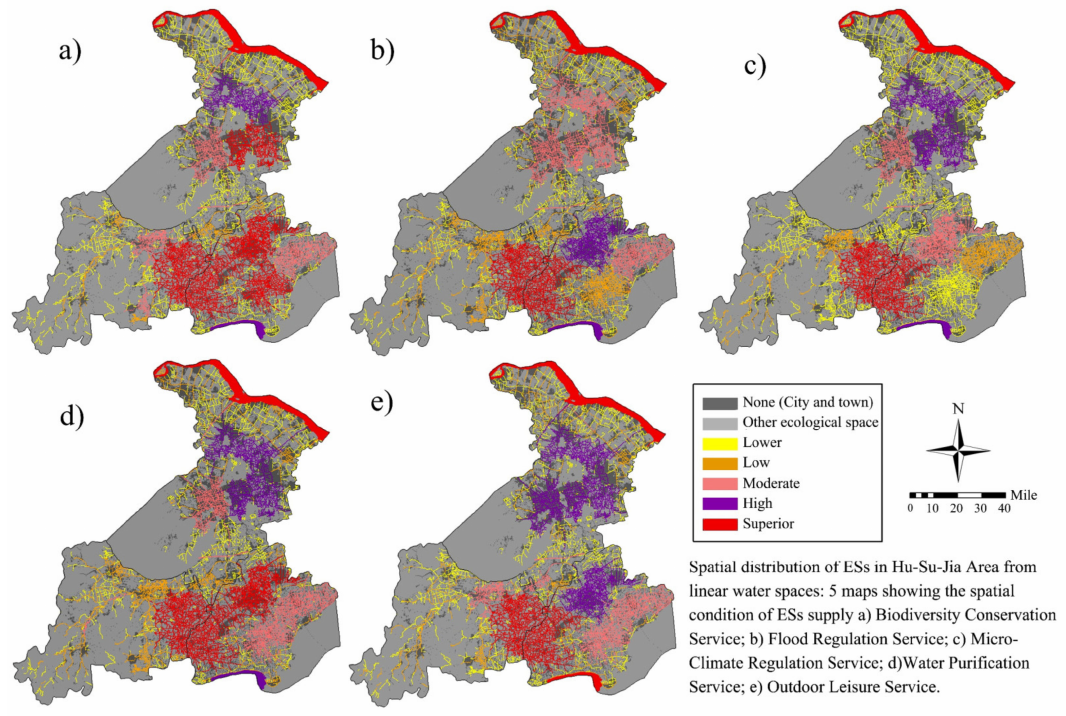
Figure 5. Mapping of five single ESs of linear water spaces in the Hu-Su-Jia area: ( a ) Biodiversity conservation service; ( b ) Flood regulation service; ( c ) Micro-climate regulation service; ( d ) Water purification service; ( e ) Outdoor leisure